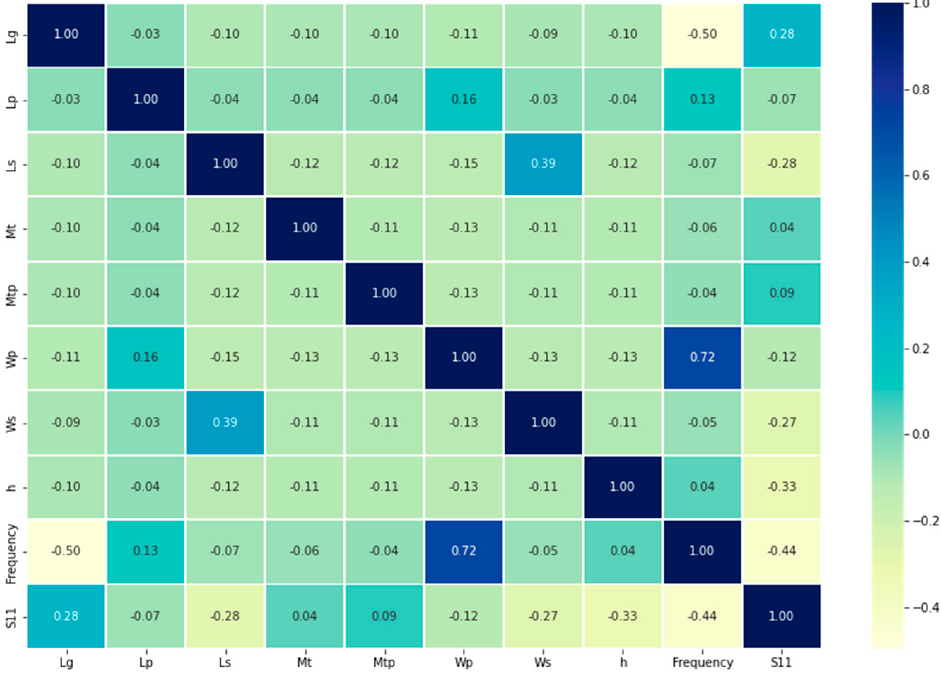
Figure 13. Correction matrix. Table 3. Simulated and predicted resonant frequency comparison of the test set using DTR.